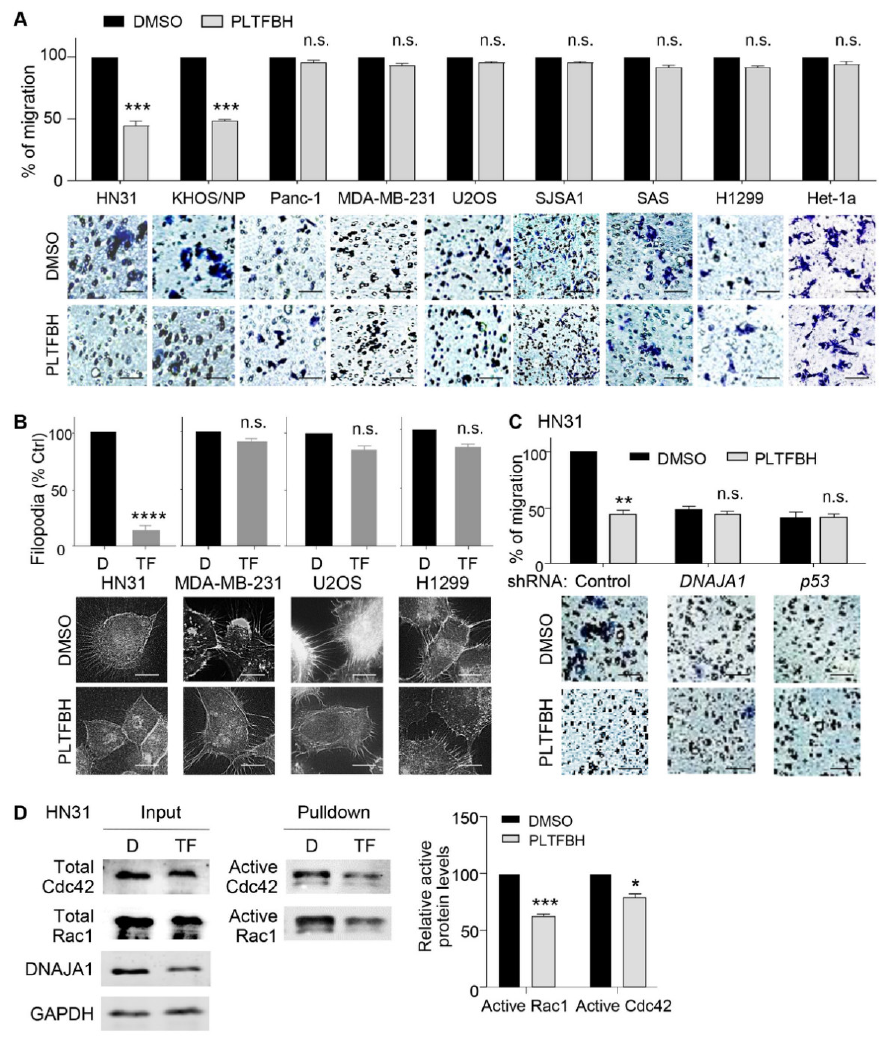
Figure 4. PLTFBH inhibits migratory potential of cancer cells in a manner dependent on DNAJA1 and conformational mutp53. ( A ) Transwell migration assays using indicated cells with different p53 status treated with PLTFBH at ~1/2 IC 50 for 12 h. All cells were pre-treated with PLTFBH for 12 h, followed by trypan blue staining and transwell migration assays. Top : summarized graphs. Bottom : representative images. Mean ± SEM from three independent experiments ( n = 3). *** p < 0.001 for two-tailed Student’s t- test. n.s.: not significant. Scale bar: 100 μm. ( B ) F-actin staining showing inhi- bition of filopodia formation in HN31 cells, but not MDA-MB-231, U2OS, and H1299 cells, by PLT- FBH (TF). Top: summarized graph. Bottom : representative images. Mean ± SEM from three inde- pendent experiments ( n = 3). **** p < 0.0001 for two-tailed Student’s t- test. n.s.: not significant. Scale bar: 10 μm. ( C ) Transwell migration assays using DNAJA1- or p53 -knockdown HN31 cells treated with PLTFBH at ~1/2 IC 50 for 12 h. Cells were pre-treated with PLTFBH for 12 h. Mean ± SEM from three independent experiments ( n = 3). ** p < 0.01 for two-tailed Student’s t- test. n.s.: not significant. Scale bar: 100 μm. ( D ) Rac1/Cdc42 activation assays following pulldown of active Rac1 and Cdc42 using protein extracts from HN31 cells treated with DMSO (D) or PLTFBH (TF) at ~1/2 of 24h-IC 50 . Left : representative immunoblots. Right : summarized graph. Mean ± SEM from three independent experiments ( n = 3). * p < 0.05, *** p < 0.001 for two-tailed Student’s t- test.